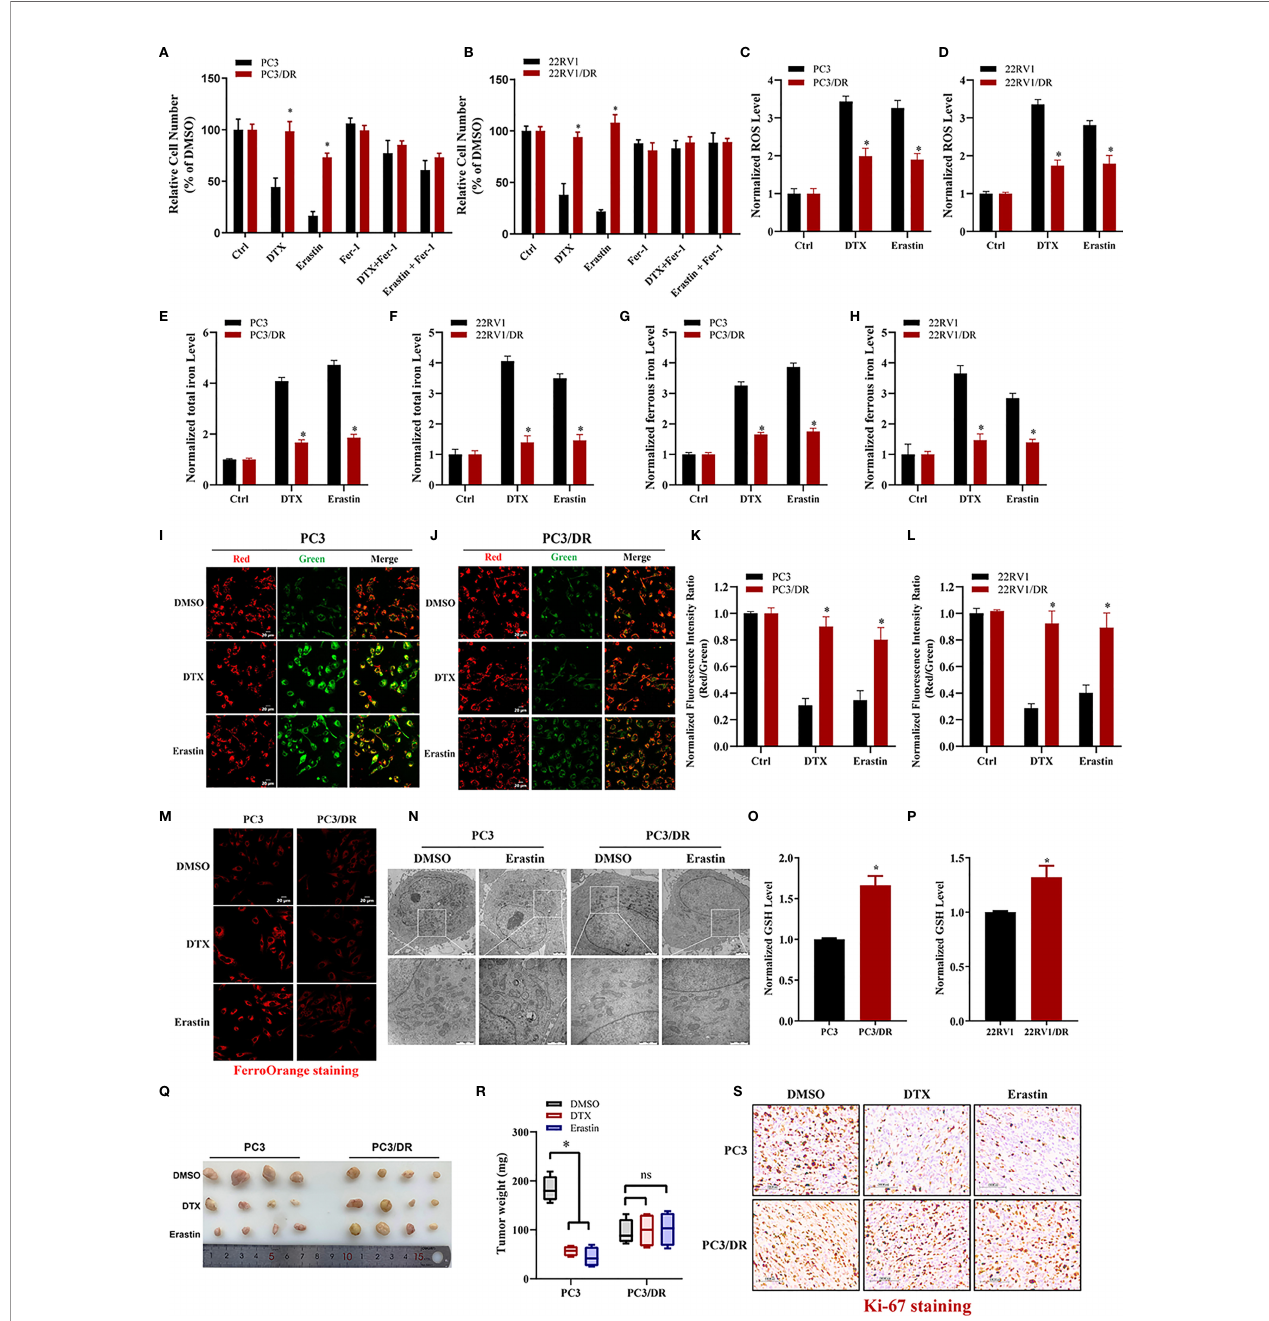
FIGURE 1 | DTX-resistant PCa cells develop tolerance toward ferroptosis. (A, B) CCK-8 assay was used to determine the response of PC3 and PC3/DR cells, 22RV1 and 22RV1/DR cells to DTX (10nM), erastin (5 m M) and/or ferrostatin-1 (5 m M). (C, D) Lipid ROS content was analyzed in PC3 and PC3/DR, 22RV1 and 22RV1/DR cells under DTX (10nM) or erastin (5 m M) treatment. (E – H) Levels of total iron, ferrous iron concentration were evaluated in PC3 and PC3/DR cells, 22RV1 and 22RV1/DR cells upon DTX (10nM) or erastin (5 m M) exposure. (I – L) The mitochondrial membrane potential were assessed by JC-1 assays in PC3 and PC3/DR cells, 22RV1 and 22RV1/DR cells after DTX (10nM) or erastin (5 m M) treatment. (M) FerroOrange staining showed that ferrous iron content (red) in PC3 and PC3/DR cells under DTX (10nM) or erastin (5 m M) treatment. (N) The morphological changes of mitochondria in PC3 and PC3/DR cells by erastin (5 m M) were observed by transmission electron microscope. (O, P) The GSH content was detected in PC3 and and PC3/DR cells, 22RV1 and 22RV1/DR cells. (Q, R) Representative images of xenograft tumors of PC3 and PC3/DR cells after treated with either DTX (5 mg/kg body weight), erastin (20 mg/kg body weight) or DMSO, and the tumor weight were further measured accordingly. The statistical signi fi cance of tumor weight was calculated by using two-way ANOVA. (S) H&E and IHC staining were performed to evaluate the tissue morphology and Ki-67 expression in each group. The data are presented as the mean±S.D. of at least three independent experiments. * P <0.05. ns, no signi fi